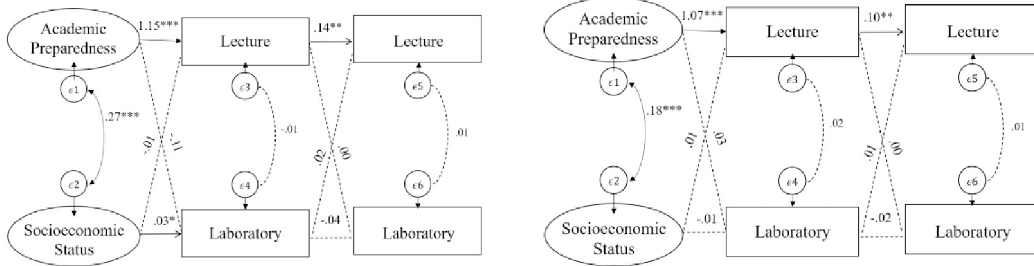
Fig 4. Multi-group structural equation model representing the associations between lecture and inquiry-based lab performance in physics course series. left: LM students, right: non-LM students; latent covariates for academic preparedness and SES are included but not shown; dashed lines describe non-significant path estimate; � p < .05., �� p < .01., ��� p <